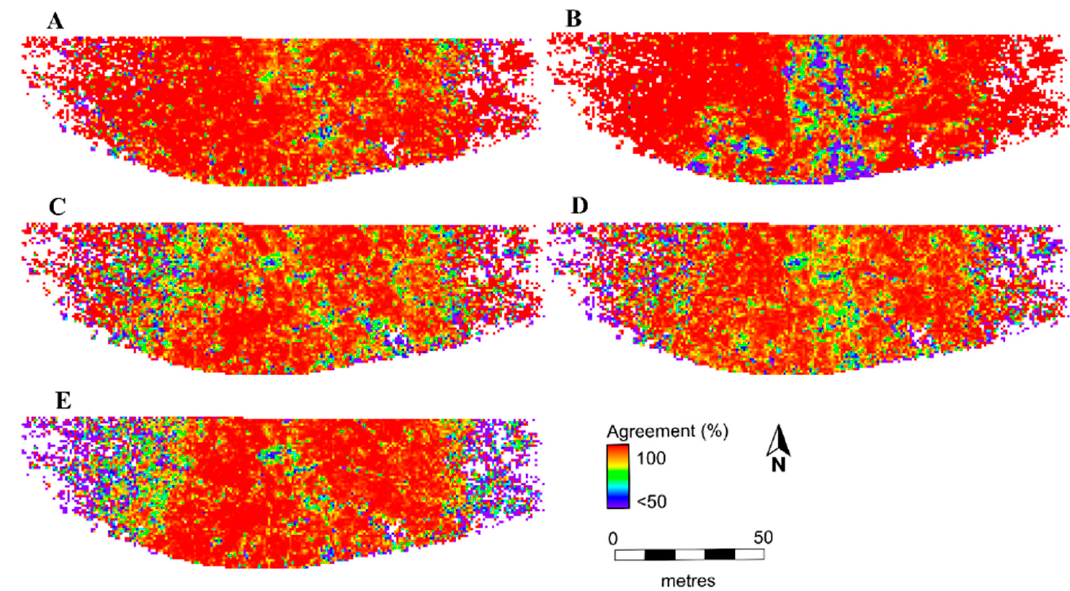
Figure 3. Rasterized classification agreement for the inverted cloth simulation ( A ), hierarchical weighted robust interpolation ( B ), progressive TIN densification ( C ), multi curvature classification ( D ), and modified slope-based filter ( E ) for the vegetated site.